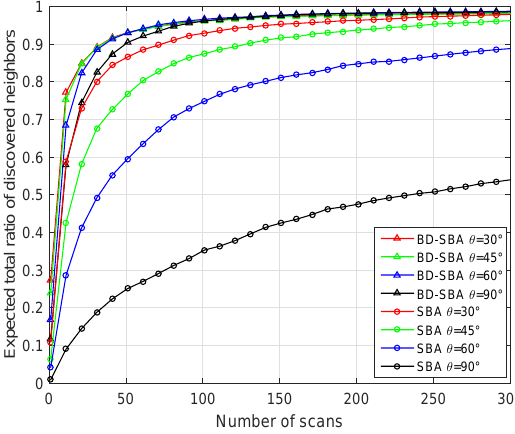
Figure 11. Performance of different sector degree. Table 1. Scan times of different sector